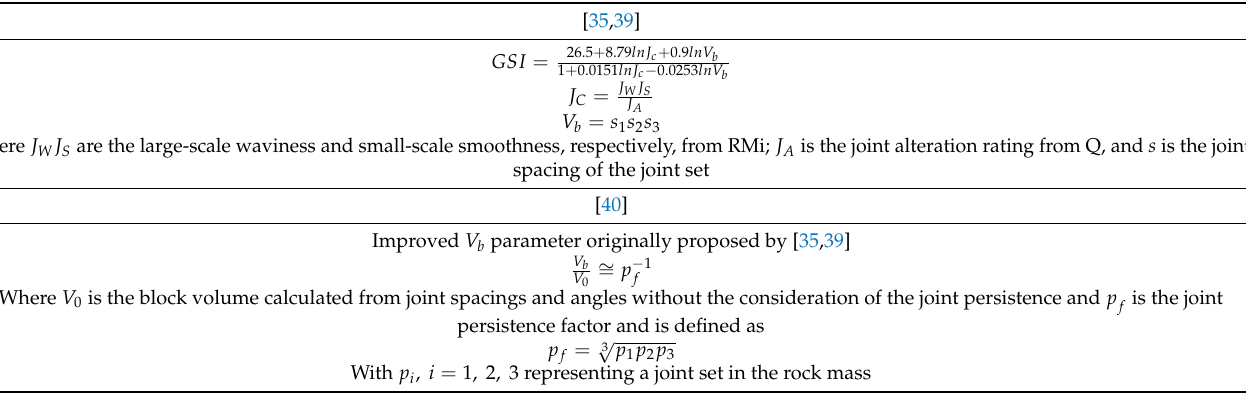
Table 3. Proposed GSI quantifications